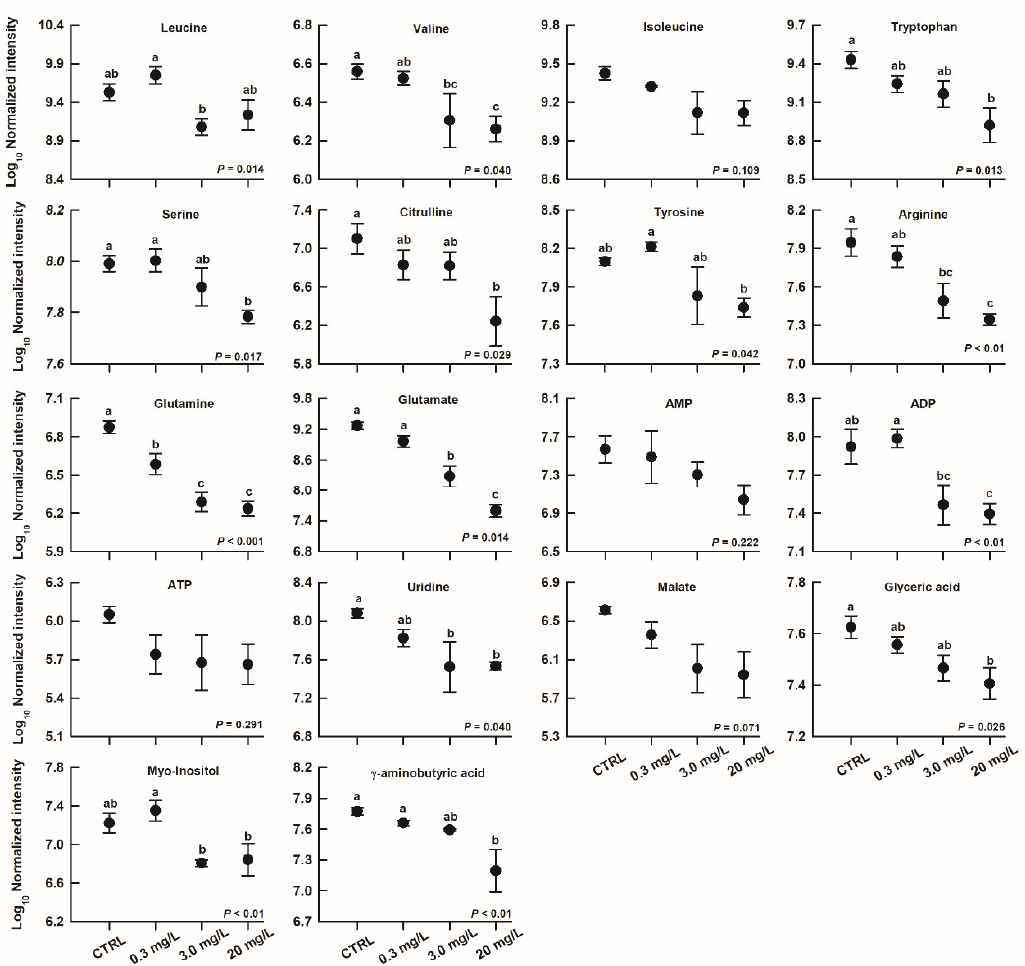
Figure 6. Mean values ( ± standard error) for several identified hepatic metabolites of Trachemys scripta elegans juveniles exposed to CTRL, 0.3, 3.0, and 20 mg/L ammonia. Different letters indicated groups that differed significantly (a > b > c).